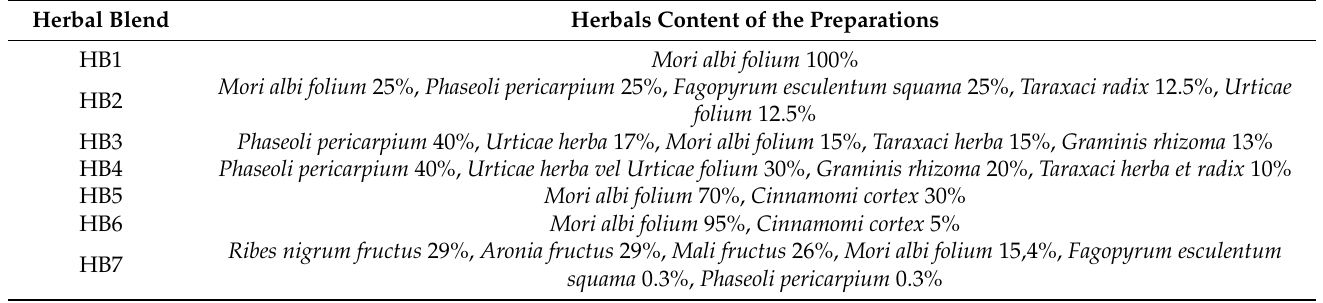
Table 1. Composition of the herbal tea blends. Herbal Blend Herbals Content of the